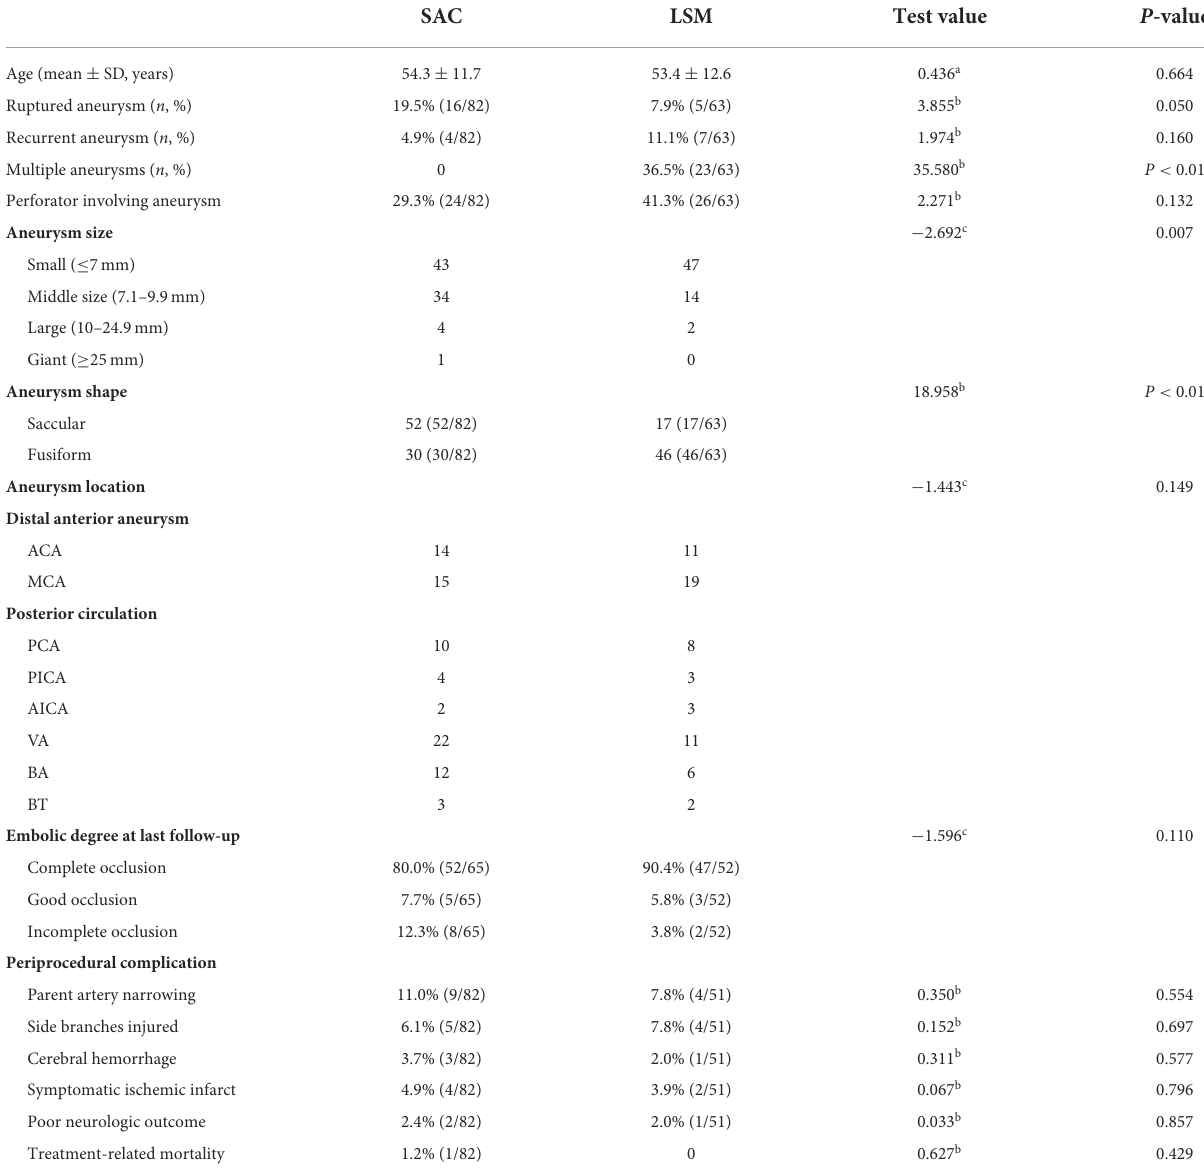
TABLE 3 The clinical information between SAC and